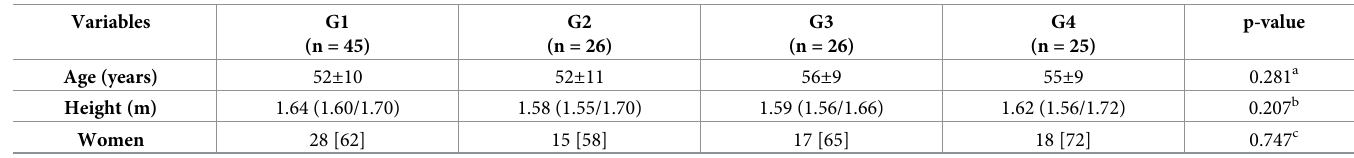
G1, uninfected control group; G2, HTLV-1-asymptomatic group; G3, possible HTLV-1-associated myelopathy (HAM) group; G4, HAM group; n, number of participants. Data are expressed as mean ± standard deviation for continuous variables with normal distribution, median (Quartil Q1/Quartil Q3) for continuous variables with non-normal distribution, and as absolute number [percentage] for categorical variables. a Analysis of variance (ANOVA) b Kruskal-Wallis test c chi-square